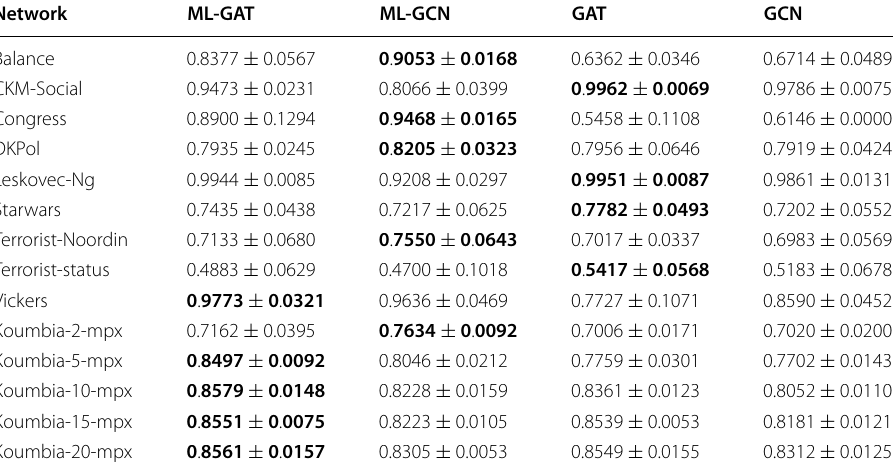
Bold values refer to the best results on each